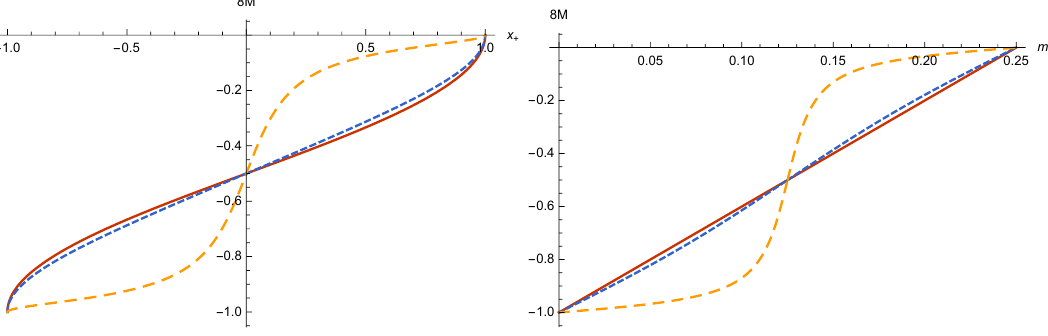
Figure 9 . The holographic mass of the conical deficit pulled by a wall plotted as a function of x + (Left) and the local “conical mass” m c (Right) with various acceleration parameters: A = 0 (solid red), A = 0 . 5 ‘ (dotted blue), A = 0 . 99 ‘ (dashed